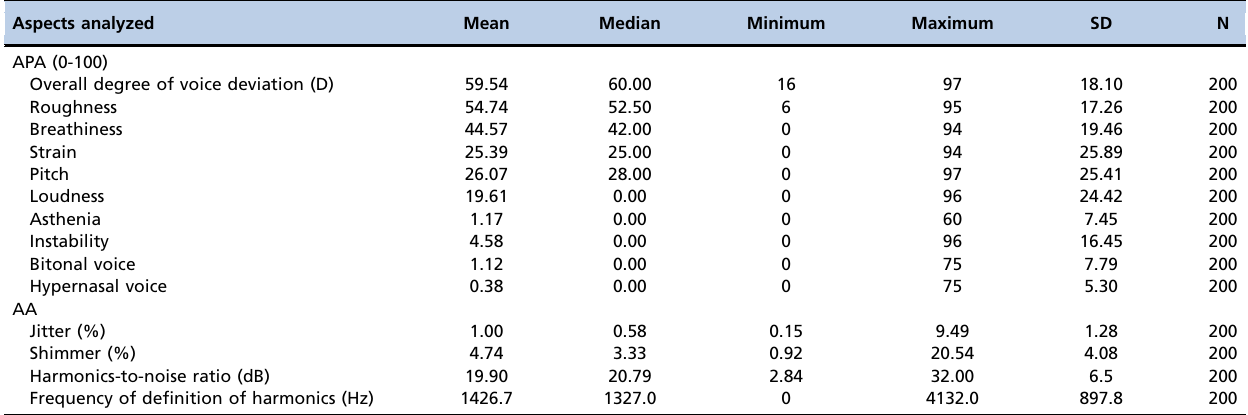
Table 1 - Distribution of numerical data related to APA and AA. Aspects